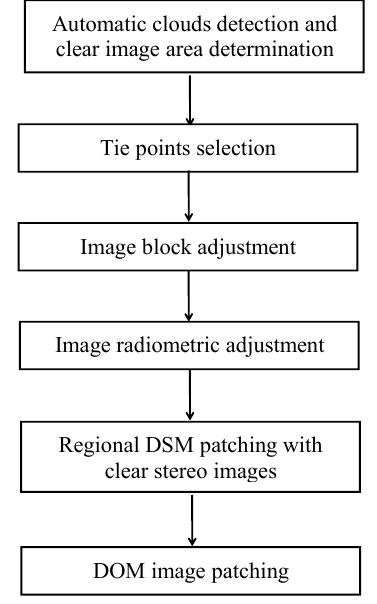
Figure 5. The workflow of automatic DSM and